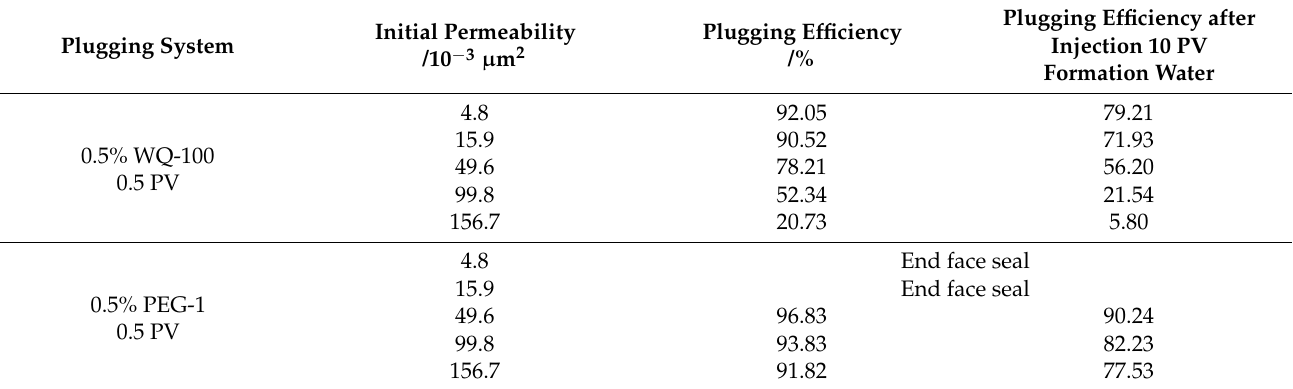
Table 5. Plugging efficiency of pre-crosslinking gel particle on the porous